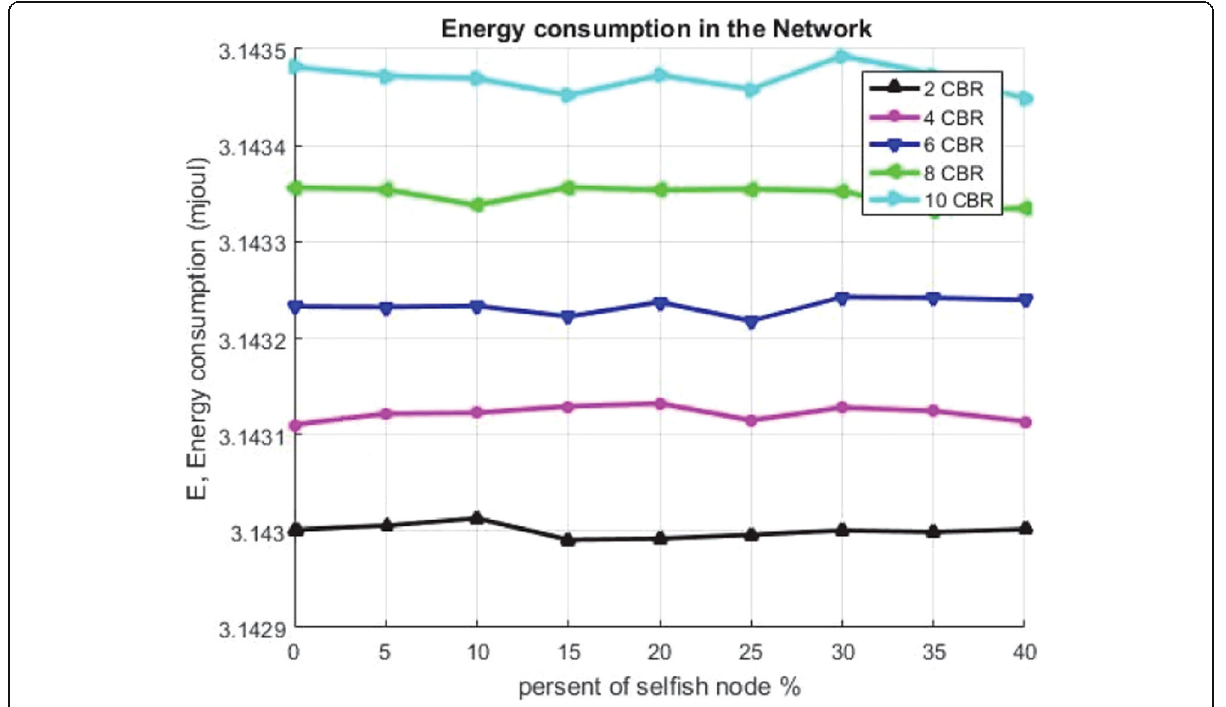
Fig. 14 Comparison of energy consumption in different traffic (2, 4, 6, 8, 10